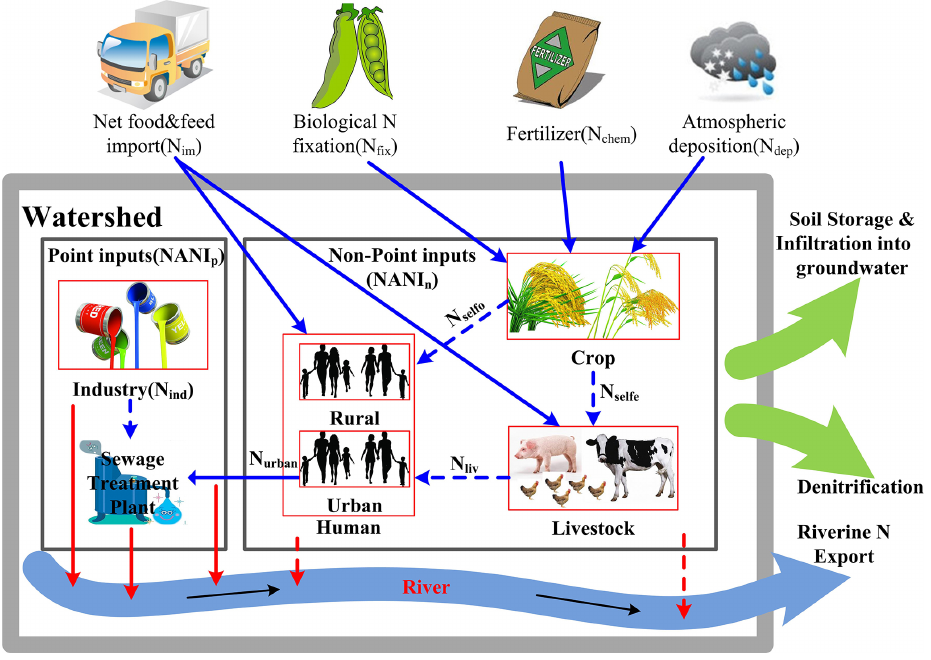
Figure 2. Diagram of major components of net anthropogenic nitrogen inputs (NANI) and exports from a watershed ecosystem (revised from Swaney et al., 2012). Within a watershed ecosystem there are two kinds of input subsystems: non-point and point systems, with large differences in the modes of N delivery. In the non-point-source system, the pollutants can be added into the river network in indirect routes, such as rainfall–runoff and leaching. In the point-source input system, the pollutants usually are discharged directly into river systems. In this estimate, the N flows with abbreviations (e.g., N im , N fix , N urban ) were included as NANI estimates. The solid blue arrows in the figure represent anthropogenic nitrogen flows, and dashed blue arrows indicate an internal cycle of nitrogen within the watershed ecosystem. The solid red arrows represent the nitrogen flows directly into river systems. The dashed red arrows indicate indirect nitrogen